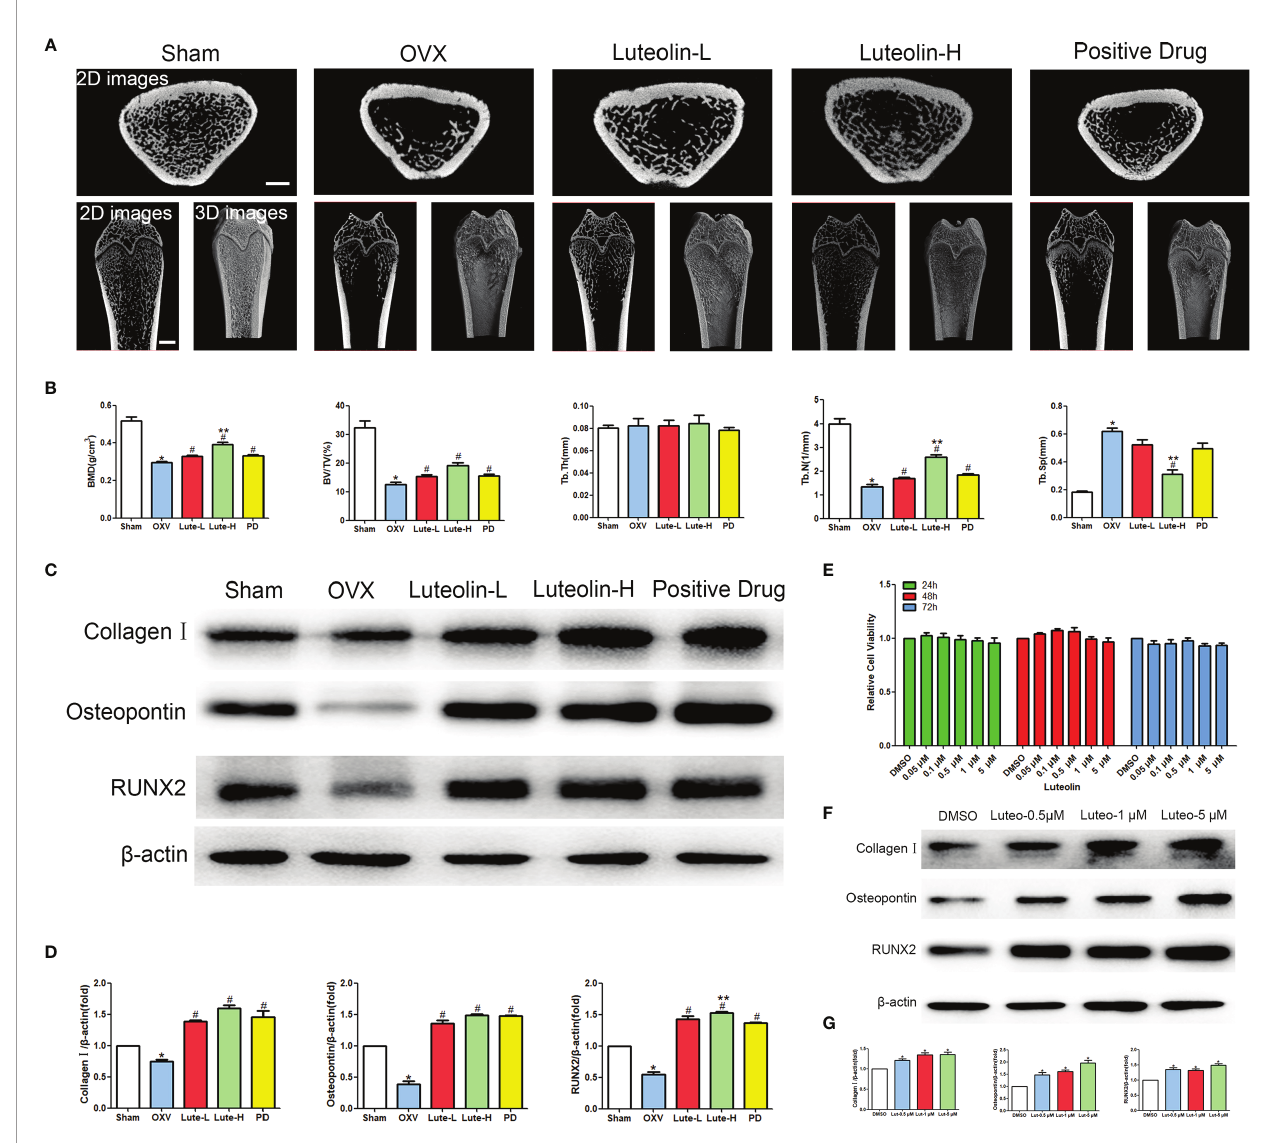
FIGURE 8 | Luteolin alleviated bone loss in OVX rats by promoting the osteogenic differentiation of BMSCs. (A) Micro-CT image of the femoral diaphysis (scale bars, 1 mm). (B) Quantitative presentation of the femoral microarchitectural parameters BMD, BV/TV, Tb.Th, Tb.N, and Tb.Sp expressed as the mean ± SD from four independent experiments. Compared with the sham group, * p < 0.05; compared with the OVX group, # p < 0.05; compared with the DG group, ** p < 0.05. (C) The expression levels of osteogenesis-related marker proteins (collagen I, osteopontin and RUNX2). (D) Comparative analysis of grey values for relevant protein bands; data are expressed as the mean ± SD from three independent experiments. Compared with the sham group, * p < 0.05; compared with the OVX group, # p < 0.05; compared with the DG group, ** p < 0.05. (E) BMSCs were treated with luteolin at increasing concentrations (0.05 m M, 0.1 m M, 0.5 m M, 1 m M, and 5 m M) for 24, 48 and 72 h, after which the OD value was determined by CCK-8 assay. Cell viability is expressed as the mean ± SD from four independent experiments. There was no signi fi cant difference. (F) BMSCs were treated with luteolin at increasing concentrations (0.5 m M, 1 m M, and 5 m M) for 48 h, after which osteogenesis-related marker protein (collagen I, osteopontin, RUNX2) expression was analysed with WB. (G) Comparative analysis of grey values from relevant protein bands; data are expressed as the mean ± SD from three independent experiments. Compared with the DMSO group, * p <